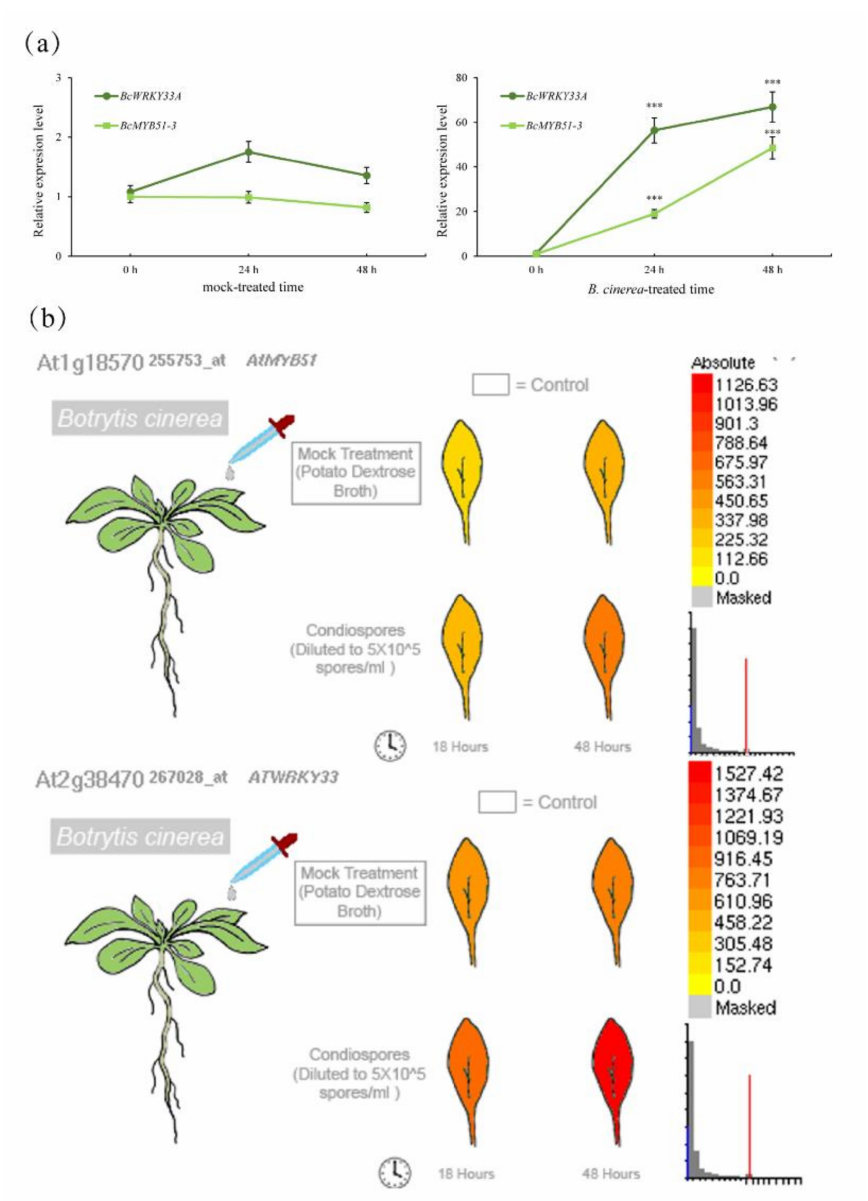
Figure 5. The similar expression patterns of BcWRKY33A and BcMYB51-3 . ( a ) The similar expression patterns of BcWRKY33A and BcMYB51-3 upon B. cinerea infection at 2 dpi. Error bars represent SD. The data are the mean ± SD of three biological replicates. *** p < 0.001 (Student’s t -test). ( b )Transcriptome data showing that B. cinerea infection can induce the expression level of MYB51 and WRKY33 (data from the Arabidopsis eFP Browser, http://bar.utoronto.ca; accessed on 20 May